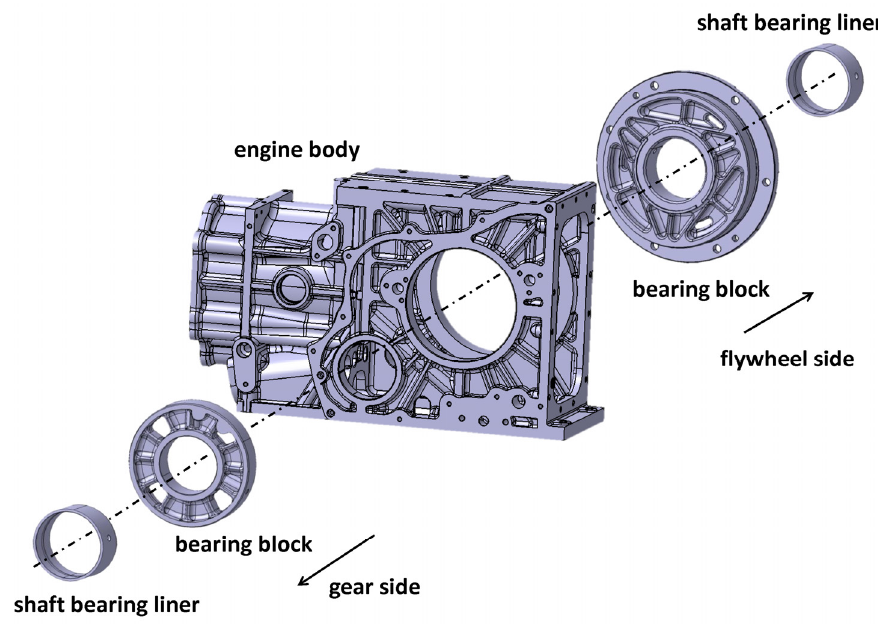
Figure 10. Support system of sliding crankshaft bearing.